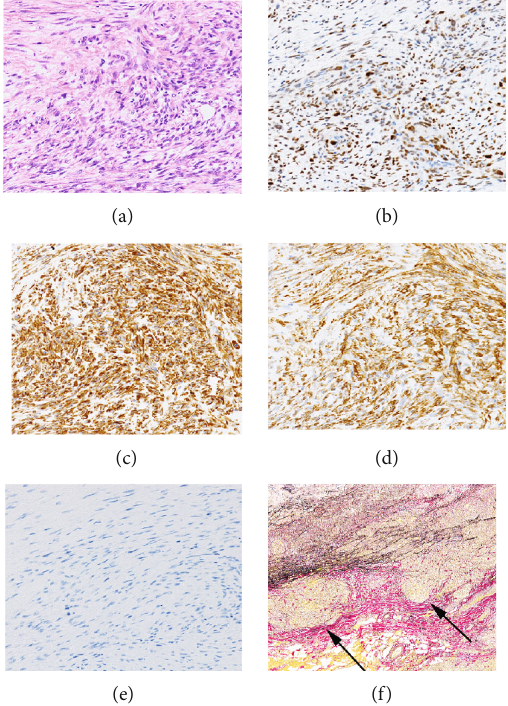
Figure 4: Histopathology of intimal sarcoma ( × 200). (a) Hematoxylin and eosin stain showing atypical spindle-shaped tumor cells. (b) Immunohistochemical staining showing positive staining for murine double minute type 2 homologue. (c) Immunohistochemical staining showing positive staining for vimentin. (d) Immunohistochemical staining showing positive staining for alpha smooth muscle actin. (e) Immunohistochemical staining showing negative staining for desmin. (f) Elastica-van- Gieson staining showed tumor cells invading outside pulmonary artery. Arrows indicate that the wall of pulmonary artery was destroyed by tumor